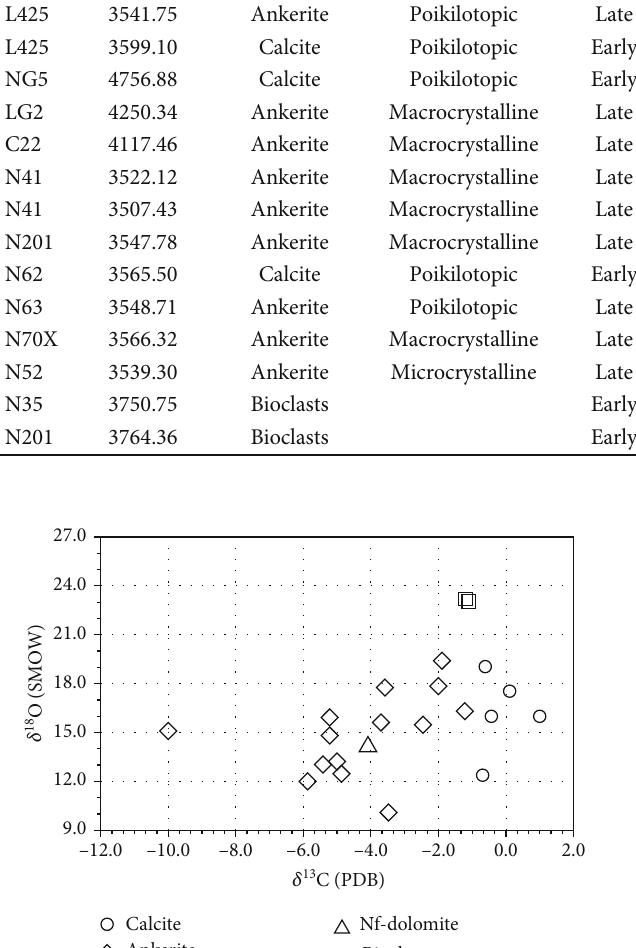
Table 3: Mineralogical and isotopic composition of carbonate cements, and calculated formation temperature of cements in the Es sandstone reservoirs.